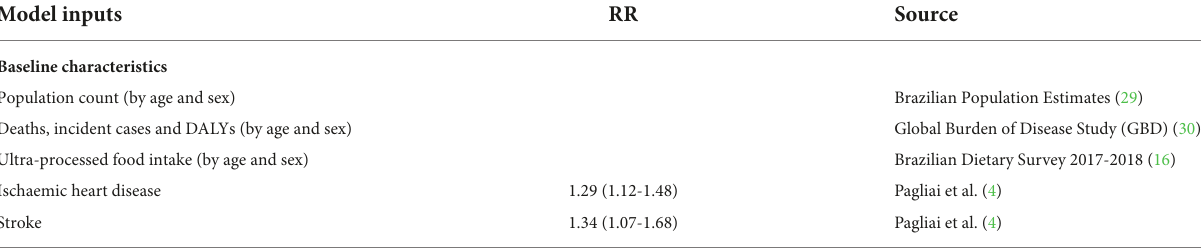
TABLE 1 Comparative risk assessment model input parameters to estimate the burden of cardiovascular diseases attributable to the consumption of ultra-processed foods in Brazil, 2019. Model inputs RR Baseline